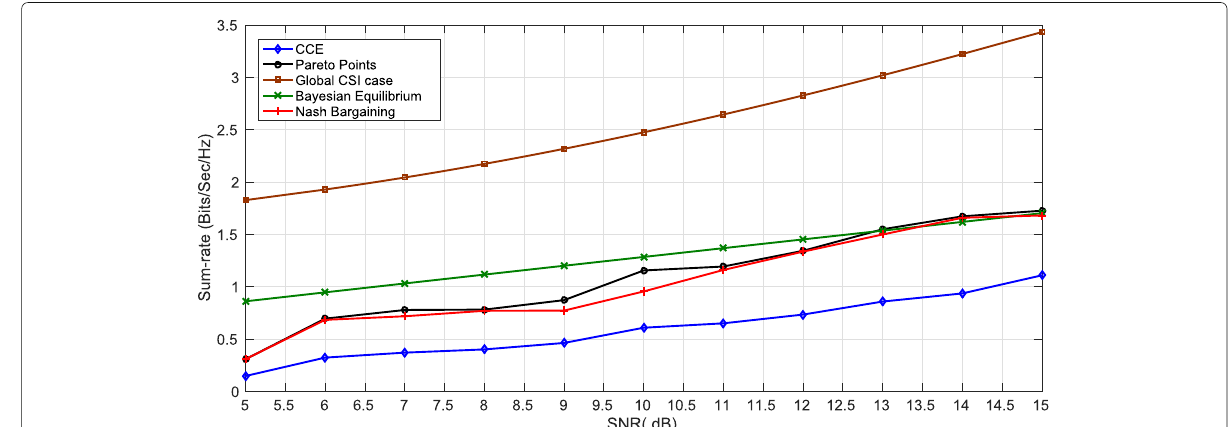
Fig. 5 F-MAC: sum-rate comparison for our scheme vs existing schemes